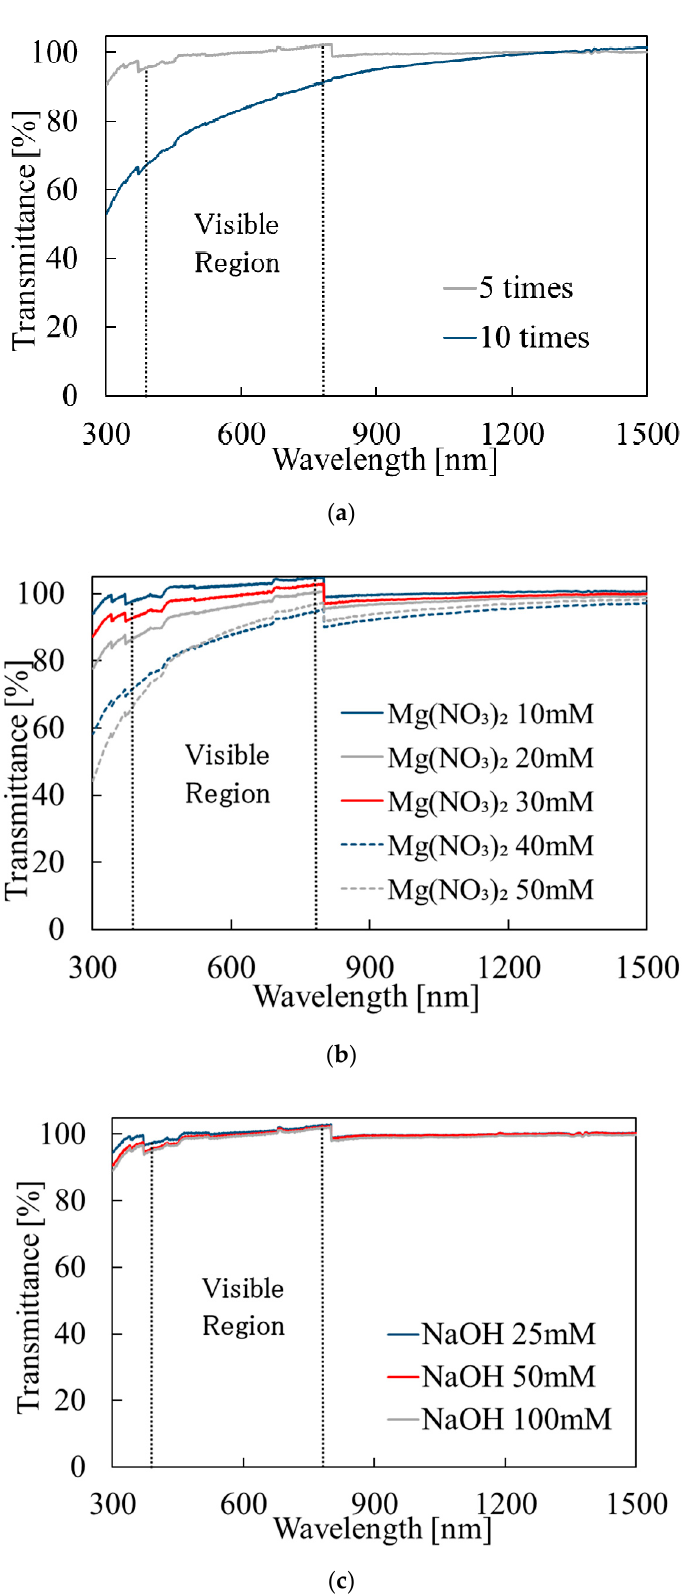
Figure 2. Optical transmittance under each deposition condition: ( a ) change in the number of depositions; ( b ) change in Mg(NO 3 ) 2 concentration; ( c ) change in NaOH concentration. (The steps near 800 nm were caused by sensor changes in the spectrophotometer, and we failed to calibrate the signal